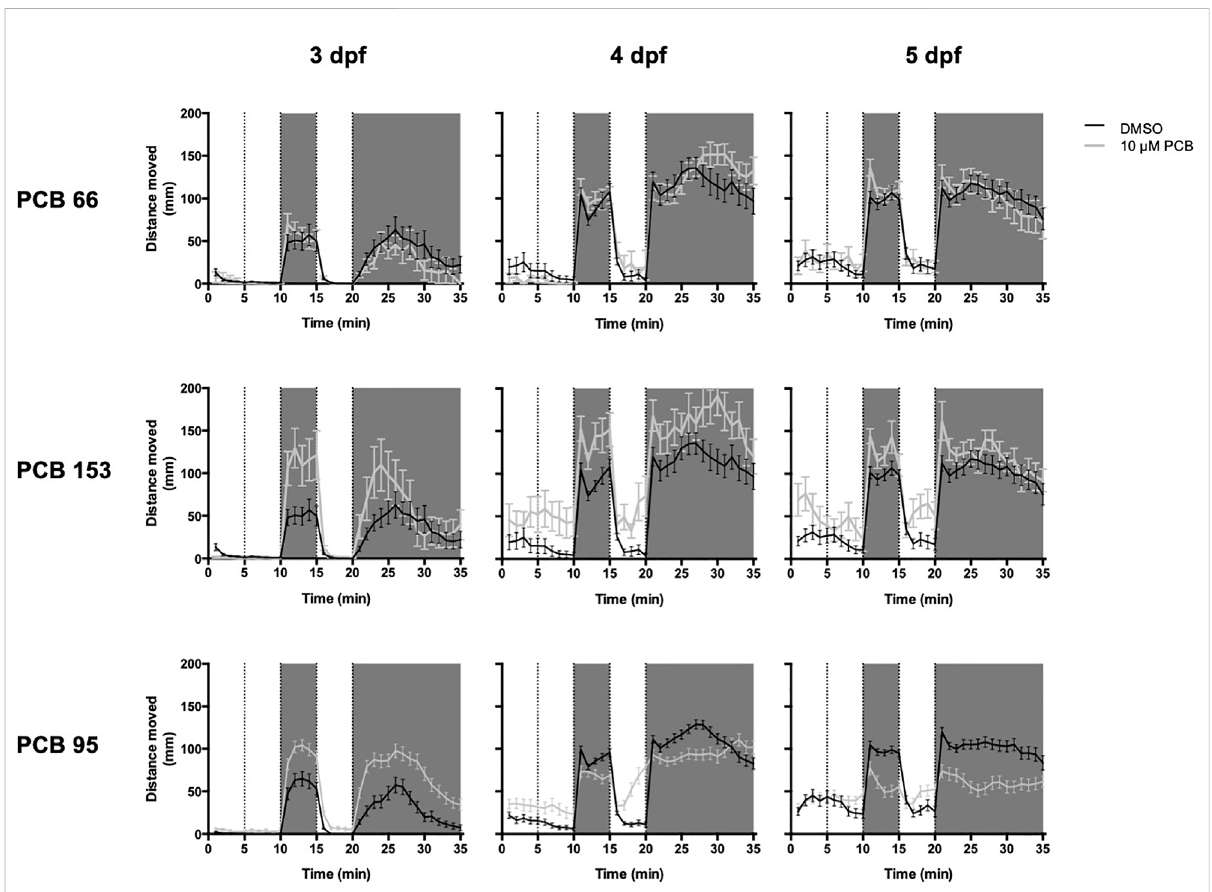
Dark2.Shadedareascorrespondtodarkperiods.Dataarepresentedasmean±SEM( n =74,74,and55forPCB95-exposedembryosand n =75,75, and 60 for vehicle control embryos on 3, 4, and 5 dpf,